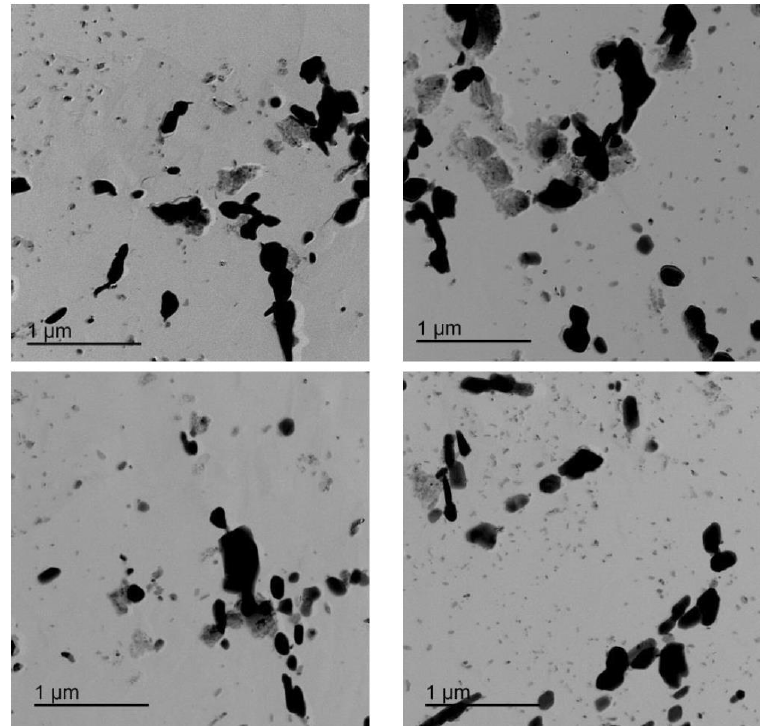
Figure A4. Failed crept cross-weld specimen 91-HAZ-3-5 600 °C 112 MPa 3216 h (sample B). TEM images on a carbon extraction replica at 50,000X.